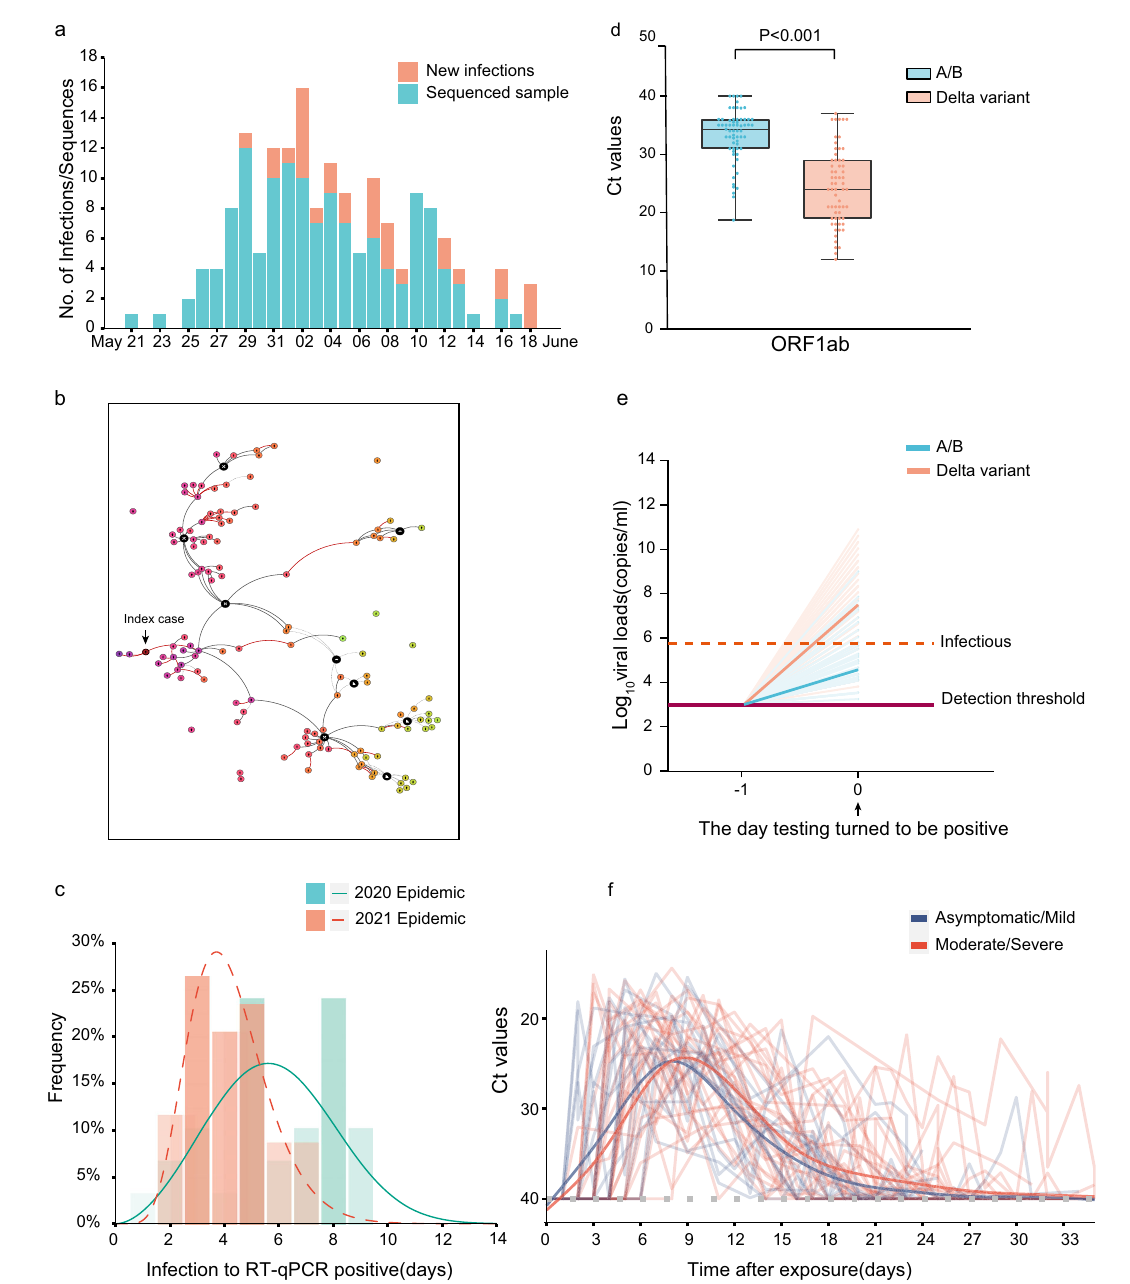
Fig. 1 Summary of the epidemiology and early detection of the Delta SARS-CoV-2 variant in Guangdong. a Time series of 167 laboratory-con fi rmed infections originating from the fi rst index case on 21 May 2021. Daily numbers of new infections are shown in red and samples with high-quality sequences (coverage >95%) are shown in blue. b The Delta variant transmission in the Guangzhou outbreak. The transmission relationship between 126 sequenced cases was indicated with solid lines (high con fi dence) or the dash lines (unsure). The interactive version could be found at https://viz.vslashr.com/ guangdongcdc/. c Estimate of the time interval between exposure and time of the fi rst PCR + test in quarantined individuals. The curves show the best- fi tting distributions of the interval durations for Delta variant cases ( n = 46) and for A/B clade cases ( n = 29). Bars show the histograms of estimated intervals durations (days). d Two-tailed Wilcoxon signed-rank test P values ( P < 0.001), showing signi fi cant changes in Ct (Cycle threshold) values of the fi rst PCR + test in quarantined individuals, for the Delta variant infections ( n = 62) and for previous A/B clade strains infections ( n = 63). Dots represent Ct values for RT-PCR of the ORF1ab gene. Box plots indicate the median (middle line), 25th and 75th percentiles (box) and minimum and maximum value (whiskers). e Schematic of the relation between the viral growth rate and the relative viral loads on the day viruses were fi rst detected (Day 0). The viral load on Day 0 was measured. The horizontal dashed line in purple represents the detection threshold of RT-PCR testing; the dashed line in red represents the lower limit above which infectious viruses could be potentially isolated. f Temporal pro fi le of serial Ct value from quarantined individuals. Longitudinal PCR testing was performed on quarantined individuals ( N = 46, overall and strati fi ed by symptom status. The detection limit was Ct = 40. The thick lines show the trend in viral load, using smoothing splines. We only included data from the fi rst PCR + test to the fi rst PCR- test during the infection; the few re- positive tests were excluded (Supplementary data